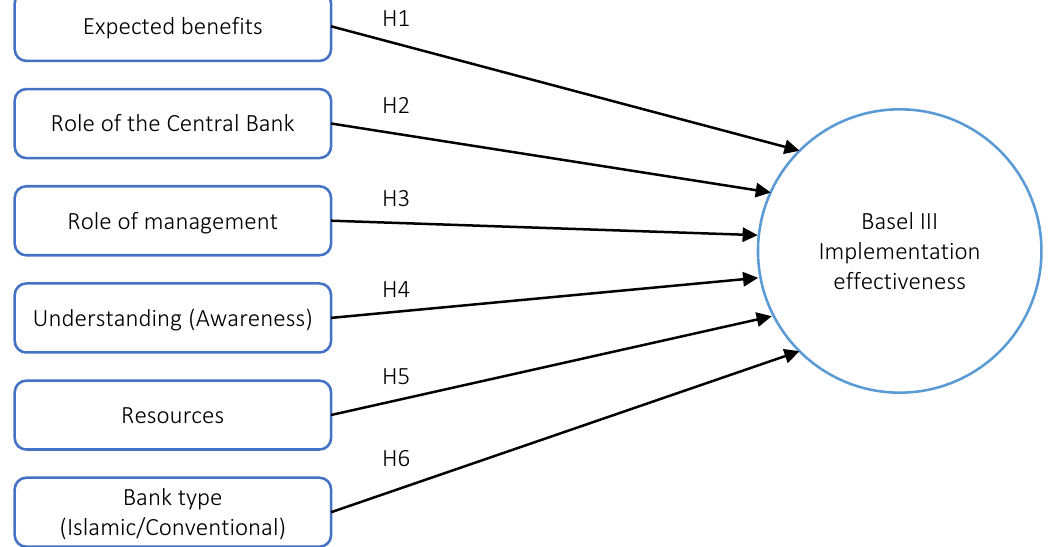
Figure 1. Theoretical